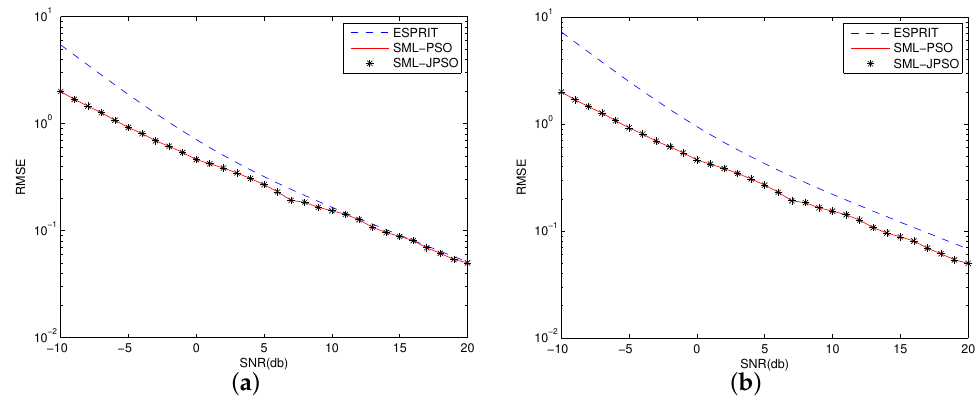
Figure 3. Root-Mean-Square-Error (RMSE) of PSO and Joint-PSO algorithms for Stochastic Maximum Likelihood (SML) and Estimation of Signal Parameters via Rotational Invariance Techniques (ESPRIT).